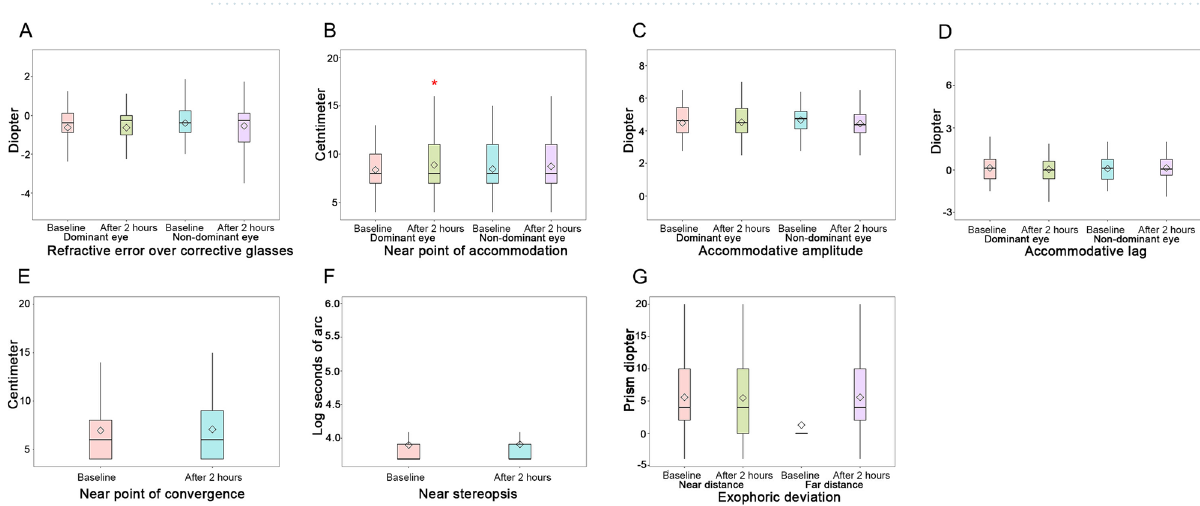
Figure 2. Changes in visual parameters after a 2-h smartphone gaming session; ( A ) refraction with glasses, ( B ) near point of accommodation ( C ) accommodative amplitude, ( D ) accommodative lag, ( E ) near-point convergence, ( F ) near stereopsis, and ( G ) exophoric deviation at the near and far